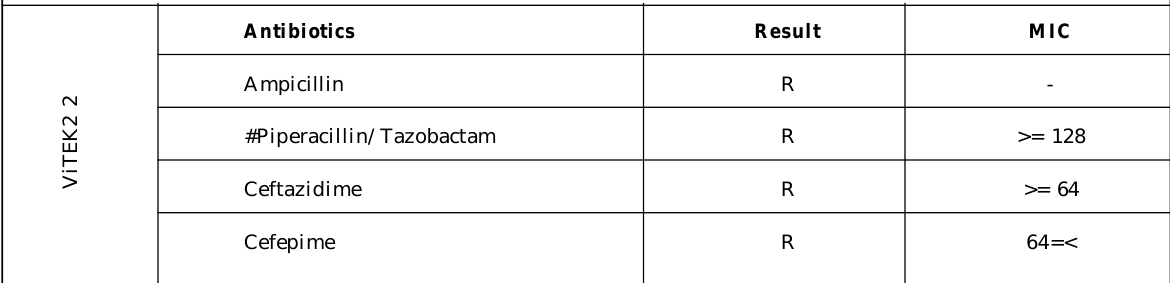
Table 2: Antibiotic resistance profiling of the clinical strain of P. aeruginosa strain A.J.